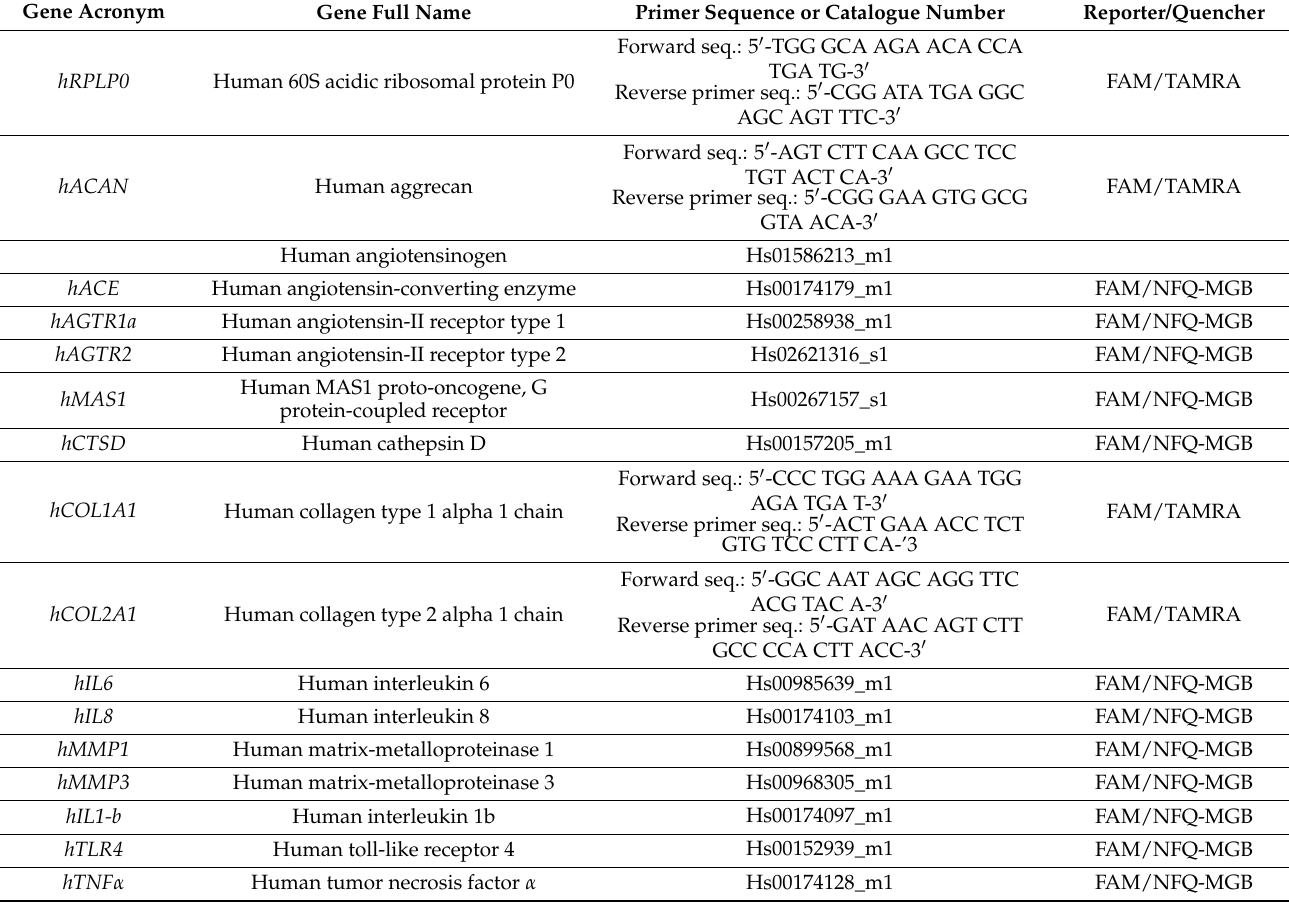
Table 3. Characteristics of custom-designed primer-probes and gene expression assays (Applied Biosystems (Waltham, MA, USA)) used for gene expression